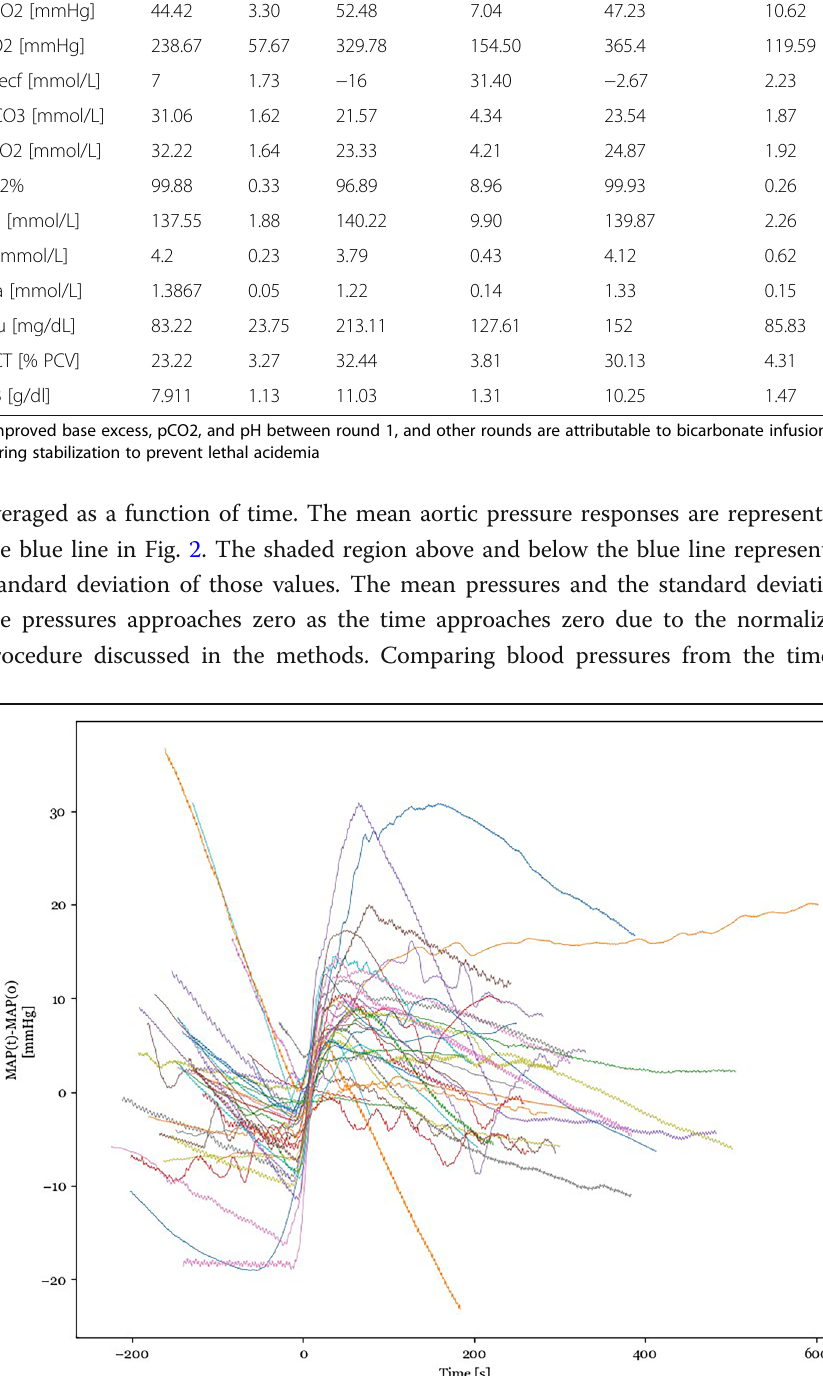
Fig. 1 Normalized mean arterial pressure tracings are shown for all 37 boluses of calcium. Displayed pressures have been smoothed using a 15-sample windowed average to reduce the ventilation artifact. There are a variety of physiological responses to a bolus of